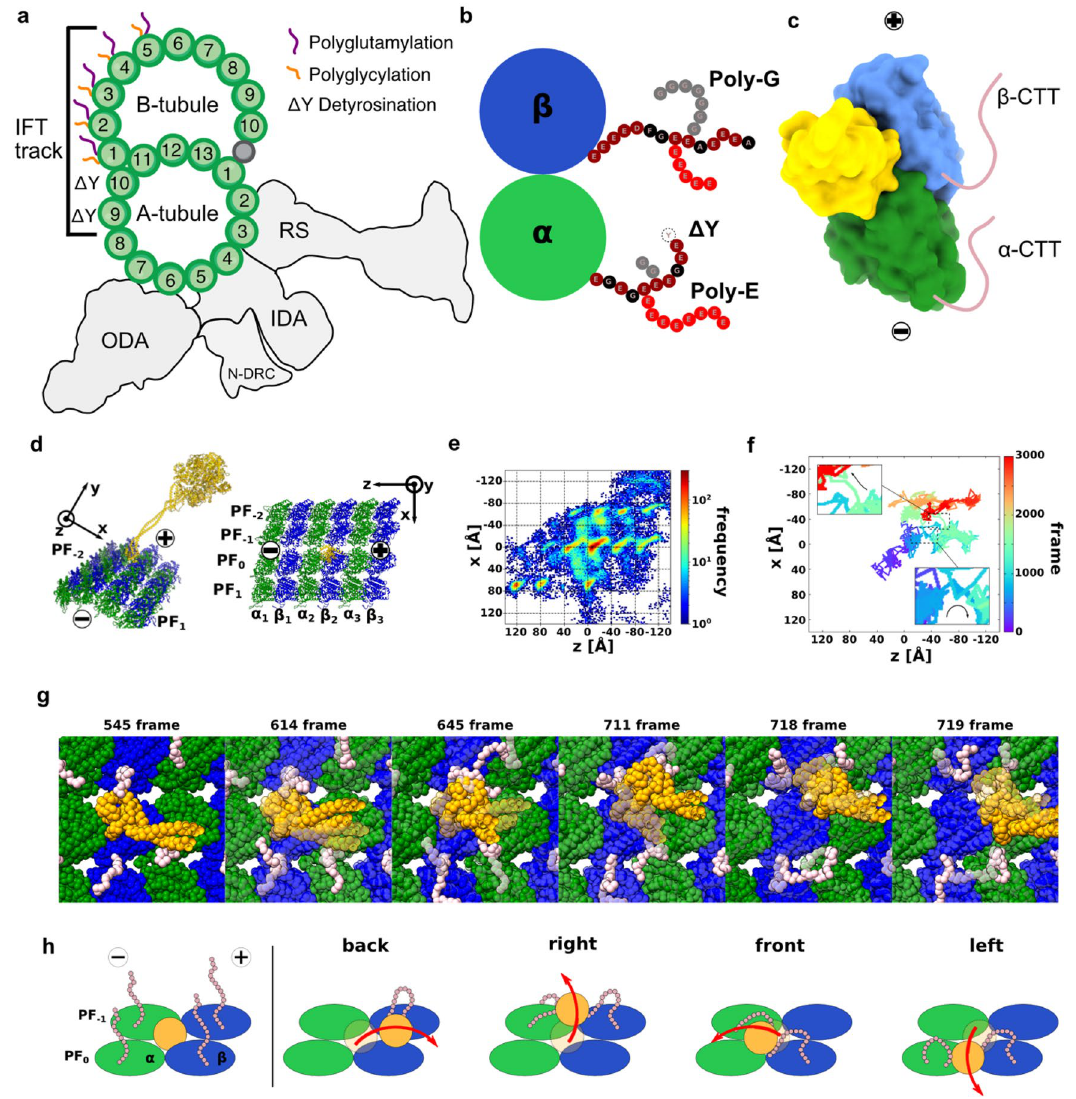
Figure 1. Low-affinity state dynein with WT MT. ( a ) Schematic of the doublet MT and the PTM distribution on the A- and B-tubules. The IFT track indicates the available PF for anterograde and retrograde IFT. ( b ) Illustration of PTM on CTT of tubulin. ( c ) Surface models of dynein-MTBD binding (from PDB 6KIQ to tubulin and the position of the flexible CTT (pink). ( d ) Simulation system of dynein and MT. Dynein, α-tubulin, and β-tubulin colored orange, green, and blue. The minus end of the MT is along the z-axis, and the circumferential direction is x-axis. ( e ) Heat map of the position of the low-affinity state MTBD on the uMT, with 20 trajectories overlaid. The frequency increases from blue to red. The red area is the stable bound for MTBD, while the blue area is the unstable within the 20 times trajectories. ( f ) Representative trajectory of MTBD on the MT. The simulation time is 3000 frames, and the trajectory changed a color from purple to red from 0 to 3000 frame. Origin is the initial position of the center of mass of MTBD. ( g ) Snapshots of a back-landing trajectory. These snapshots are picked up from Fig. 1d bottom. CTTs of α- and β-tubulins colored pink. The semi-transparent model is a previous snapshot. ( h ) Cartoons for the back, right-side, front, and left-side landing